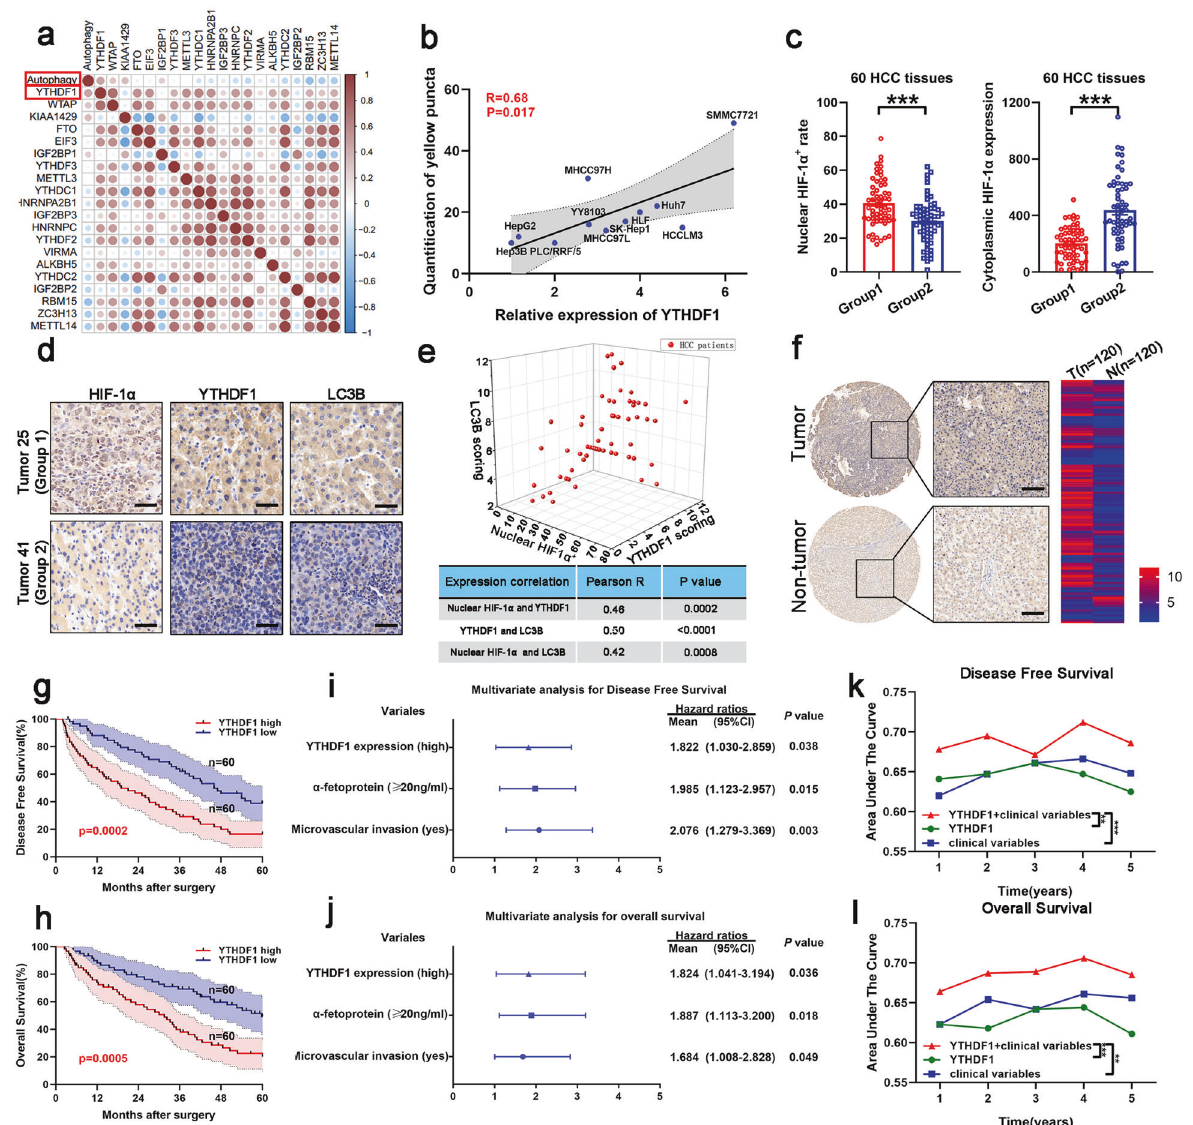
Fig. 1 Increased YTHDF1 expression is associated with poor prognosis in patients with HCC. a Relationship between m6A gene expression and hypoxia-induced autophagy in HCC cell lines using a correlation matrix. b Relationship between YTHDF1 expression and hypoxia-induced autophagy in HCC cell lines. c Immunohistochemistry (IHC) staining of HIF-1 α in human HCC tumors. d IHC staining of HIF-1 α , YTHDF1, and LC3B in human HCC tumors. Scale bar, 100 µm. e Three-dimensional scatter plot of HIF-1 α , YTHDF1, and LC3B in human HCC tumors. f Representative IHC images of YTHDF1 using HCC tissue microarray (TMA). Scale bar, 200 µm. g , h Kaplan – Meier analysis showing the disease- free survival and overall survival of HCC patients with diverse YTHDF1 expression. I , j Multivariate Cox regression analysis of disease-free survival and overall survival in patients with HCC. k , l Time-dependent receiver operating characteristic analysis for clinical risk score (microvascular invasion), YTHDF1 risk score, and combined YTHDF1 and clinical risk scores in patients with HCC. Error bars represent the mean ± SEM and the dots represent the value of each experiment; ** P < 0.01, *** P <